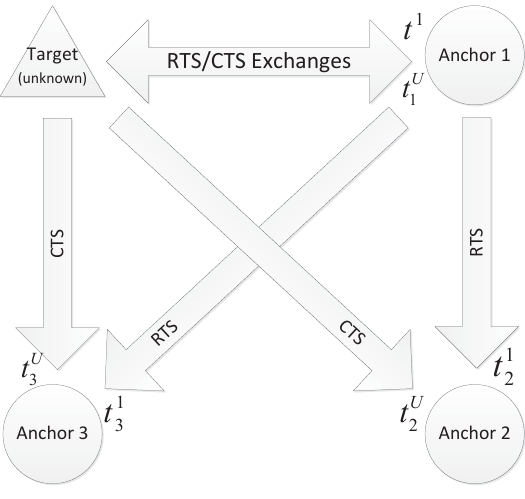
Figure 1: 3-node RTS/CTS messaging example est number of anchors for localization if we do not use RTT measurements.